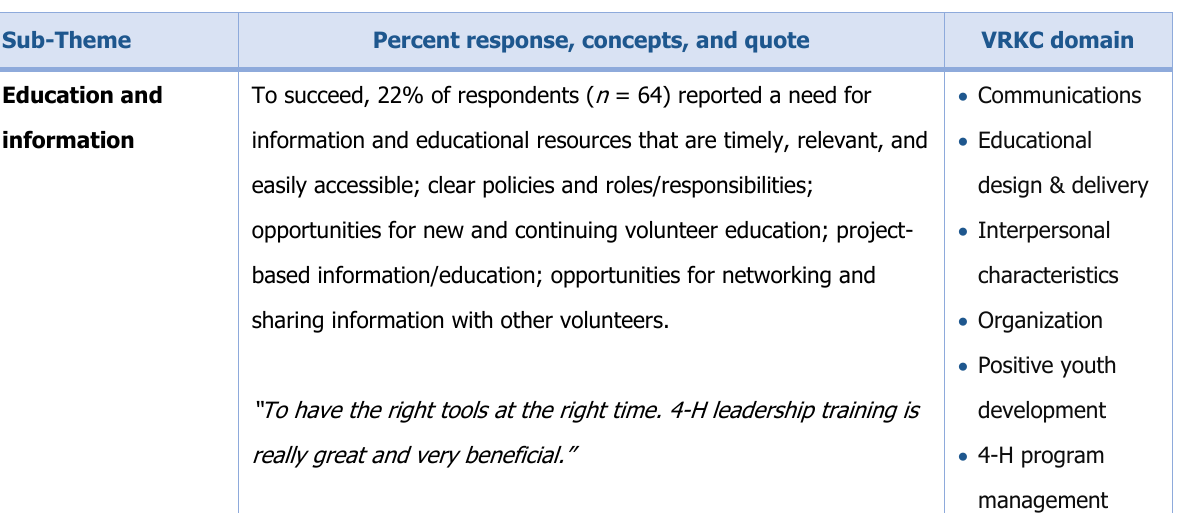
Table 9. “Needs for Success” Sub -Themes of the Program Administration and Communication